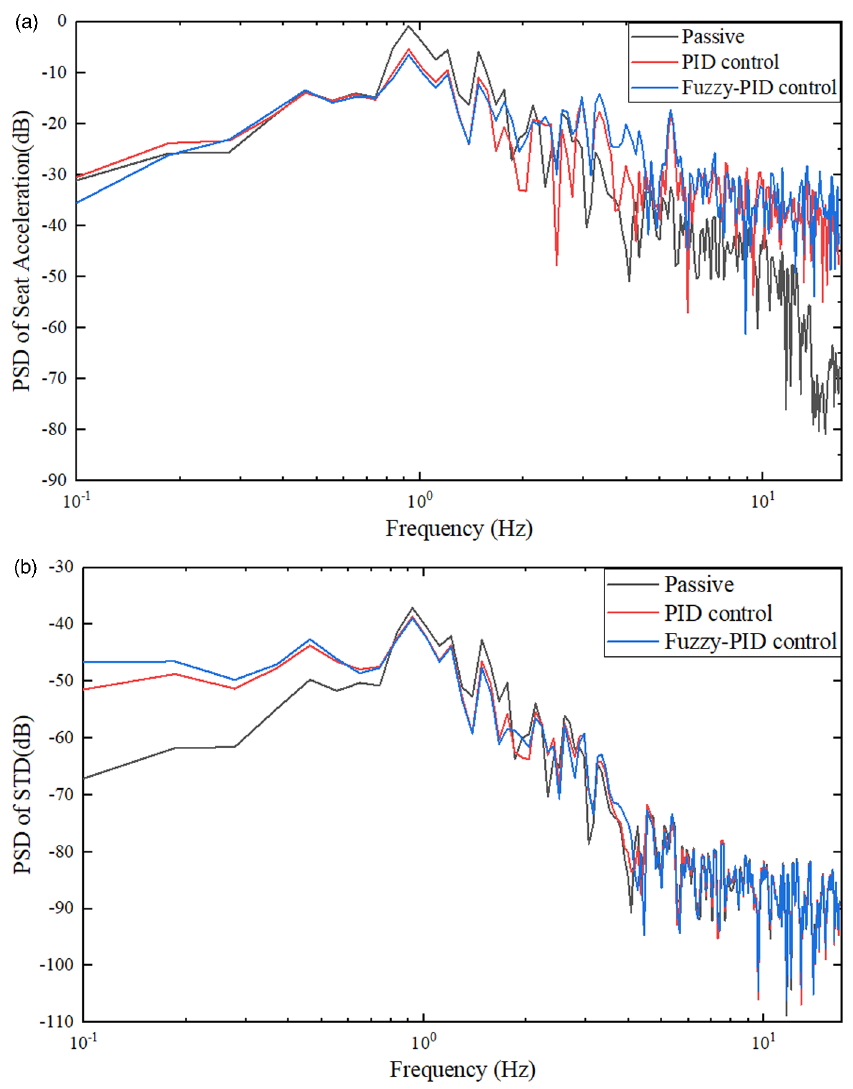
Fig. 11. Frequency domain characteristics of the seat suspension system under random excitation: (a) seat acceleration; (b) seat travel